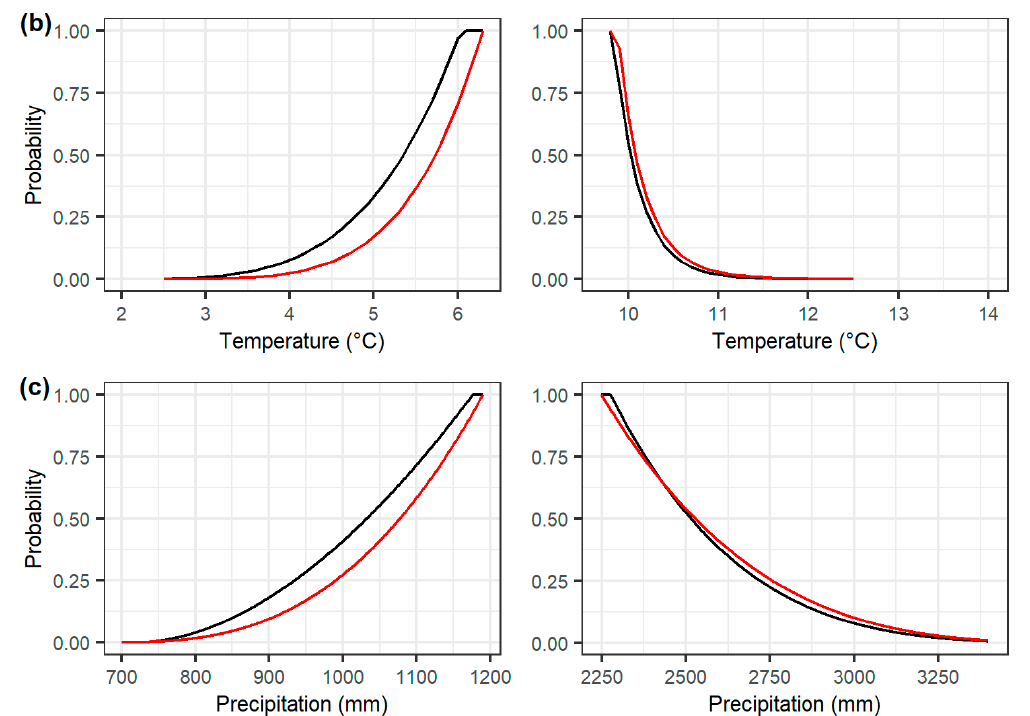
Figure 5. Occurrence probability of beech regeneration (black line) and mature beech trees (red line) at the lower (<10th percentile; left sub-figures) and upper tails (>90th percentile; right sub-figures) of the ( a ) ELV, ( b ) TEMP and ( c ) PREC distributions; the occurrence probability at the selected threshold for each life stage is assumed to be 1.